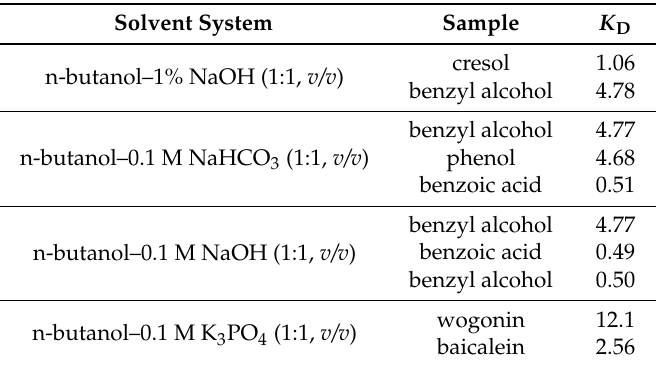
Table 1. K D of each solute in different solvent